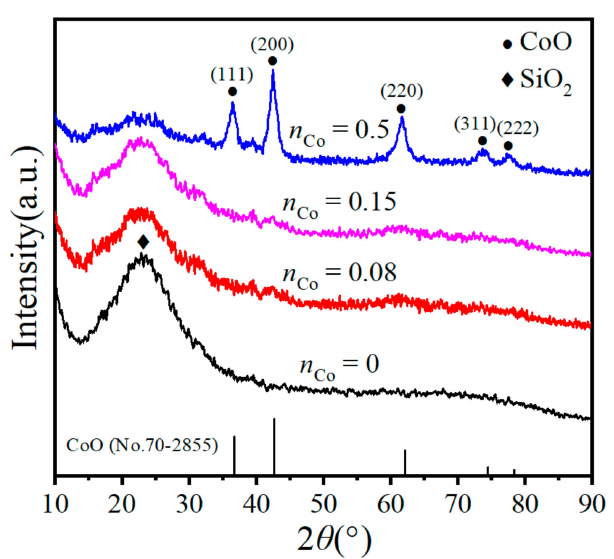
Figure 2. XRD patterns of unsupported Co/MSiO 2 materials with various n Co calcined at 400 ◦ C under N 2